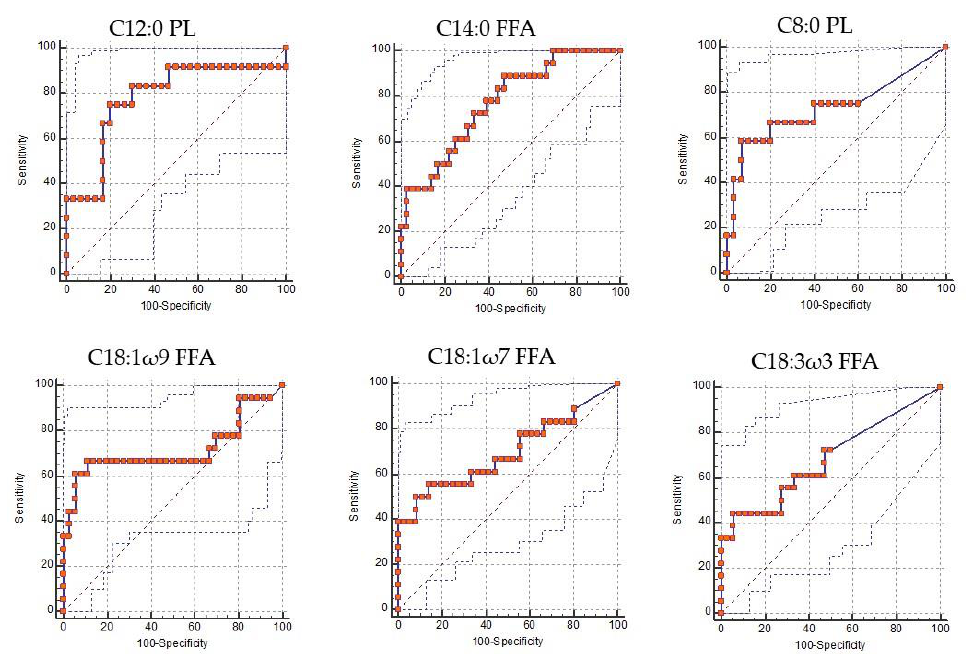
Figure 2. Receiver Operating Characteristic (ROC) curve of six predictive fatty acids with an area under the curve (AUC) higher than 0.70.